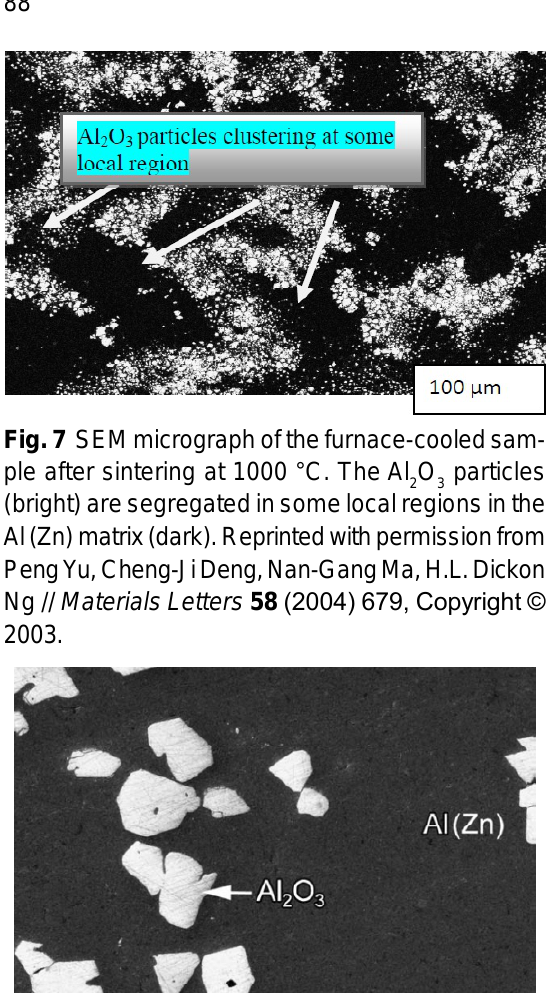
O Particles 2 3 O 2 3